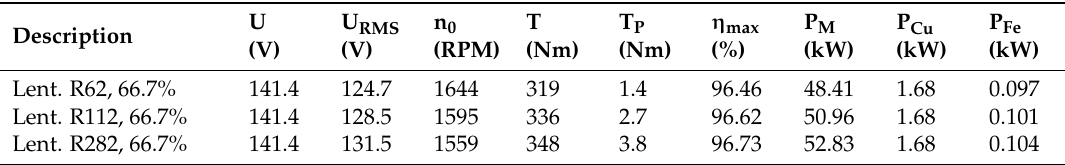
Table 4. The influence of radius changes on the surface of the lenticular magnets on the obtained ERPMSM parameters.